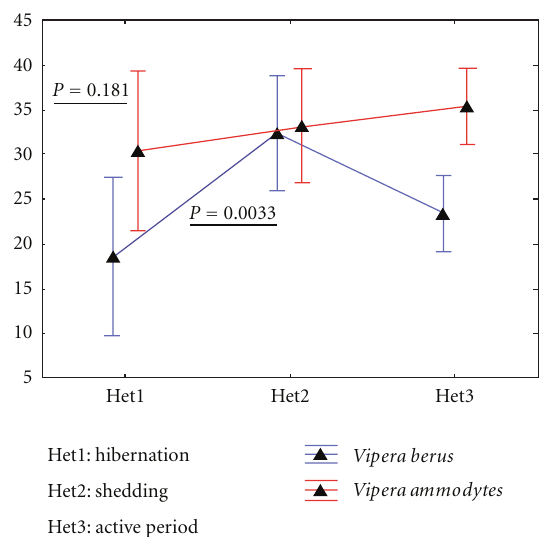
Figure 1: The dynamics of heterophiles cells in V. berus berus and V. ammodytes ammodytes in various moments of their lifecycle.